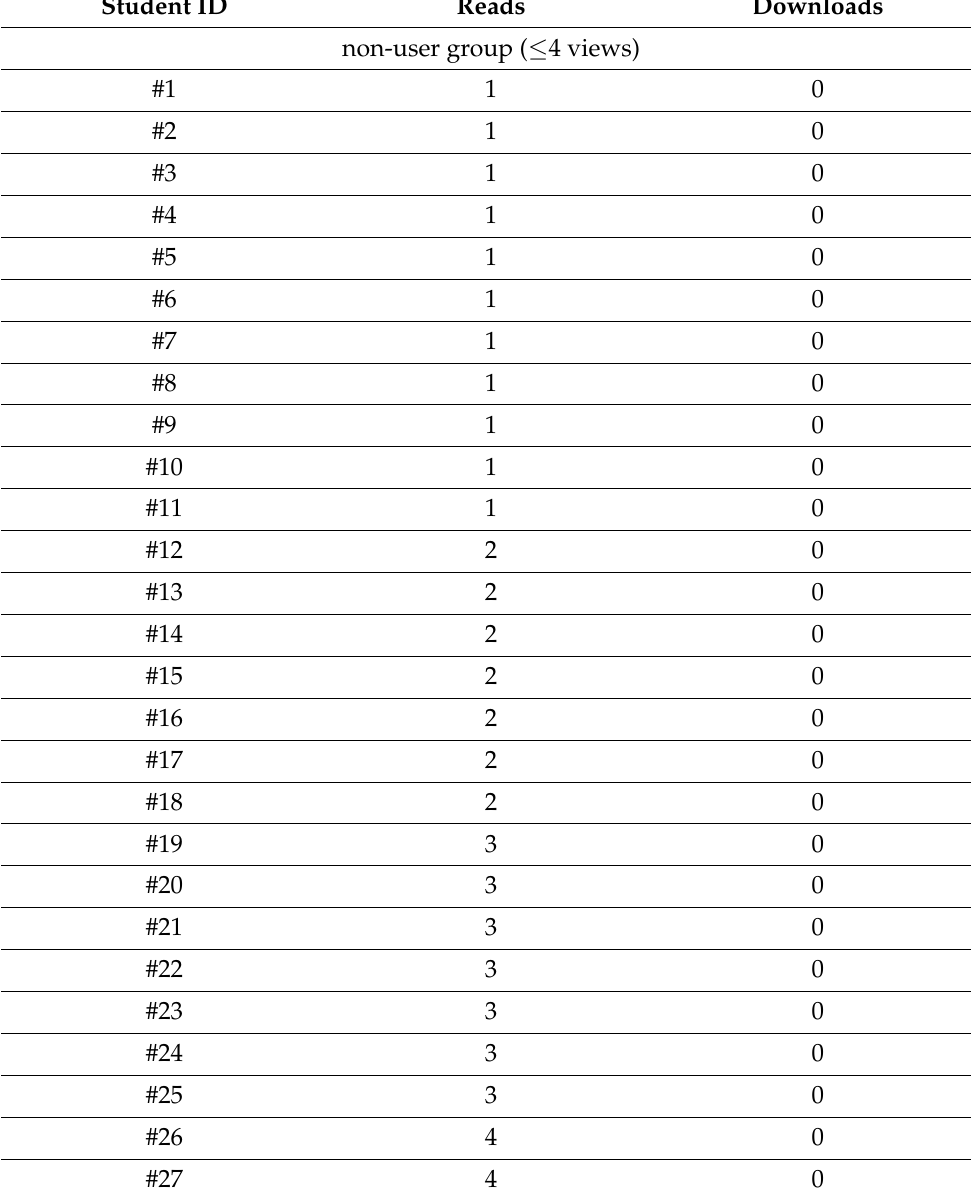
Table 2. Number of reads and downloads of the different user types during the non-pandemic study period. The number of reads and downloads during the 10-week non-pandemic study period is shown per individual user type. The definition of a user type is summarized above the respective table. Eighteen students could not be assigned to any of these four groups and are, thus, not listed in the